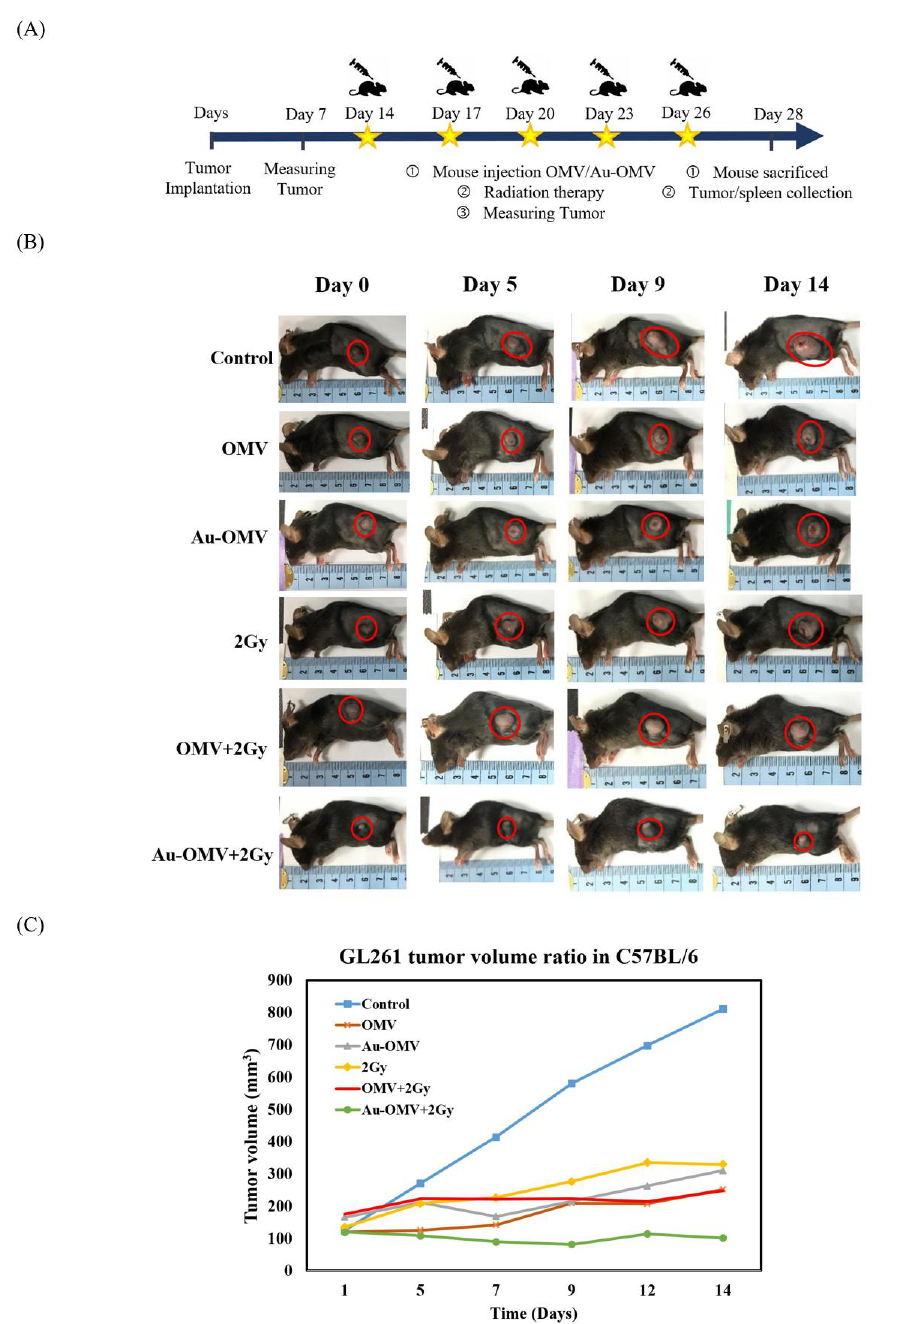
Figure 8. ( A ) Schematic diagram of subcutaneous OMV or Au–OMV injections with radiation therapy for GL261 glioma tumor-bearing mice. ( B , C ) Tumor volume kept growing in the control group, but the growth was suppressed in all treatment groups, especially in the group treated with Au–OMV + 2 Gy radiotherapy, whose tumors did not grow, even at the end of the